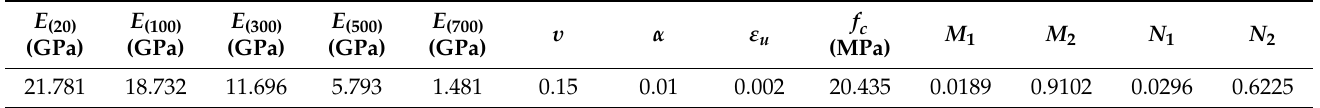
Figure 2. Calculation model for uniaxial compression of the concrete cubic element. Table 1. Constitutive model parameters for C20 concrete.